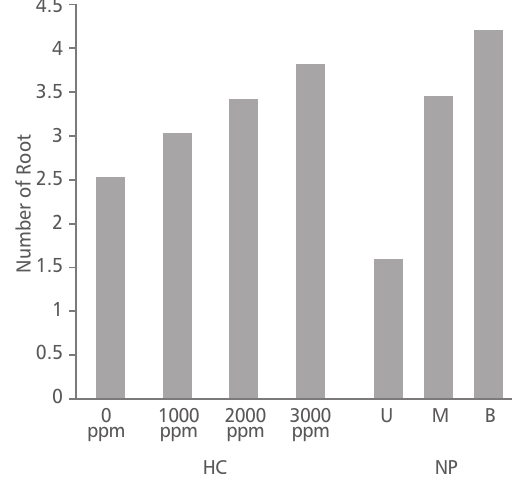
FIGURE 5. D. tripetala ramets leaf production using different IBA hormone concentration (HC) and nodal positions (NP) (U= upper node, M = middle node and B = basal